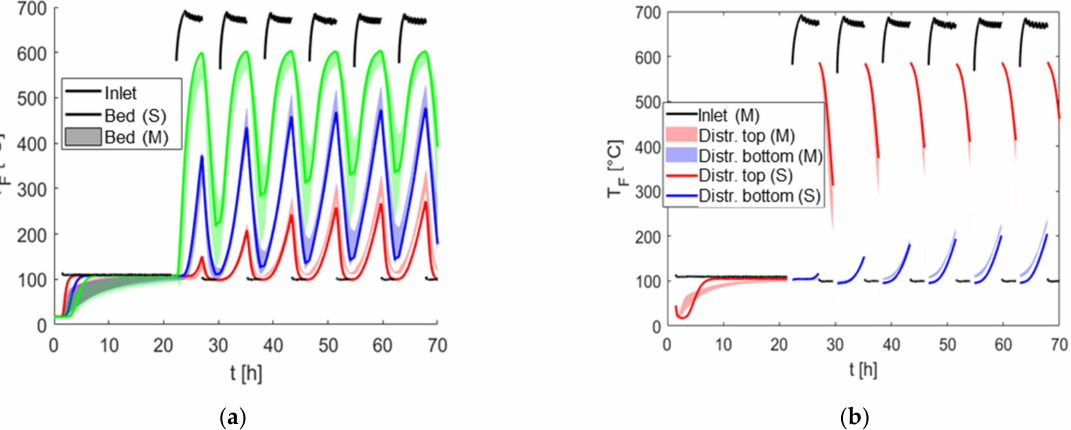
Figure 24. Test T4—Fluid temperature (TF), measurement (M), simulation (S): ( a ) temperature at bed height 0.3 m (red), 0.9 m (blue), 1.5 m (green); ( b ) temperature in the hot-side (top)/cold-side (bottom)